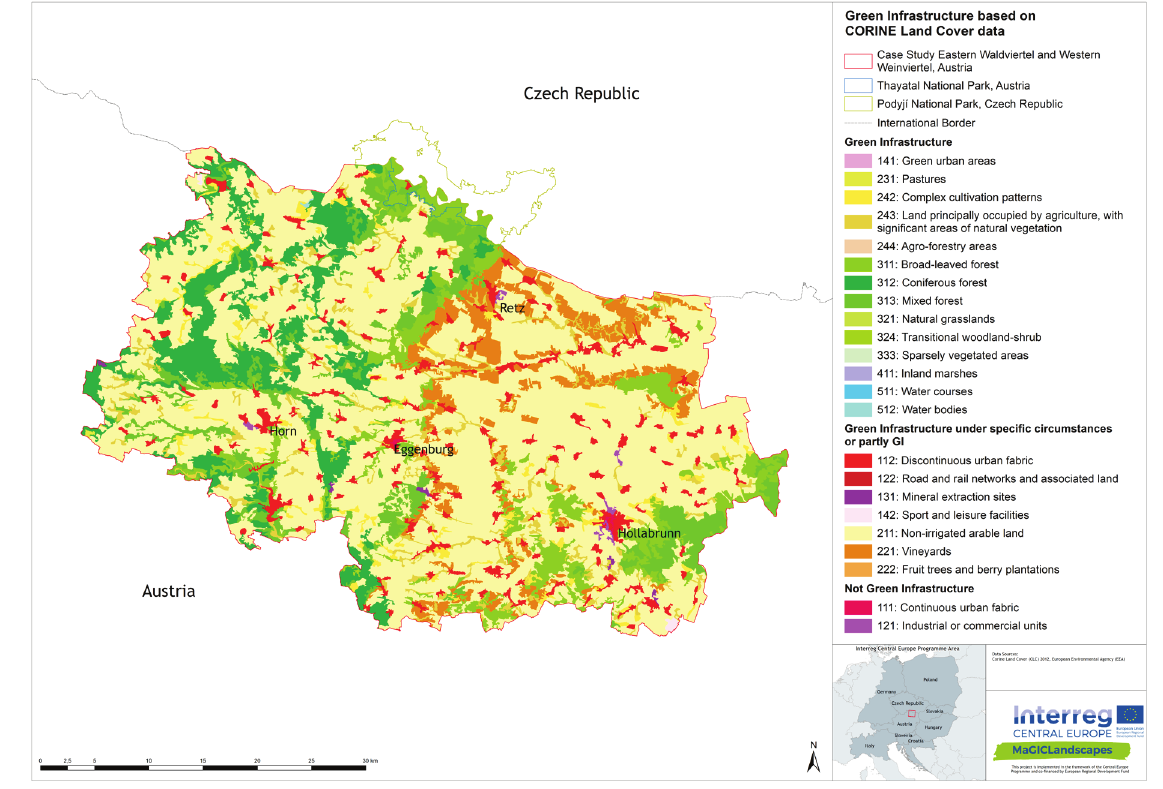
HEC-RAS.Figure Figure 3. Map of Green Infrastructure of the Austrian case study based on regional Figure 2. Schematic representation of the workflow in